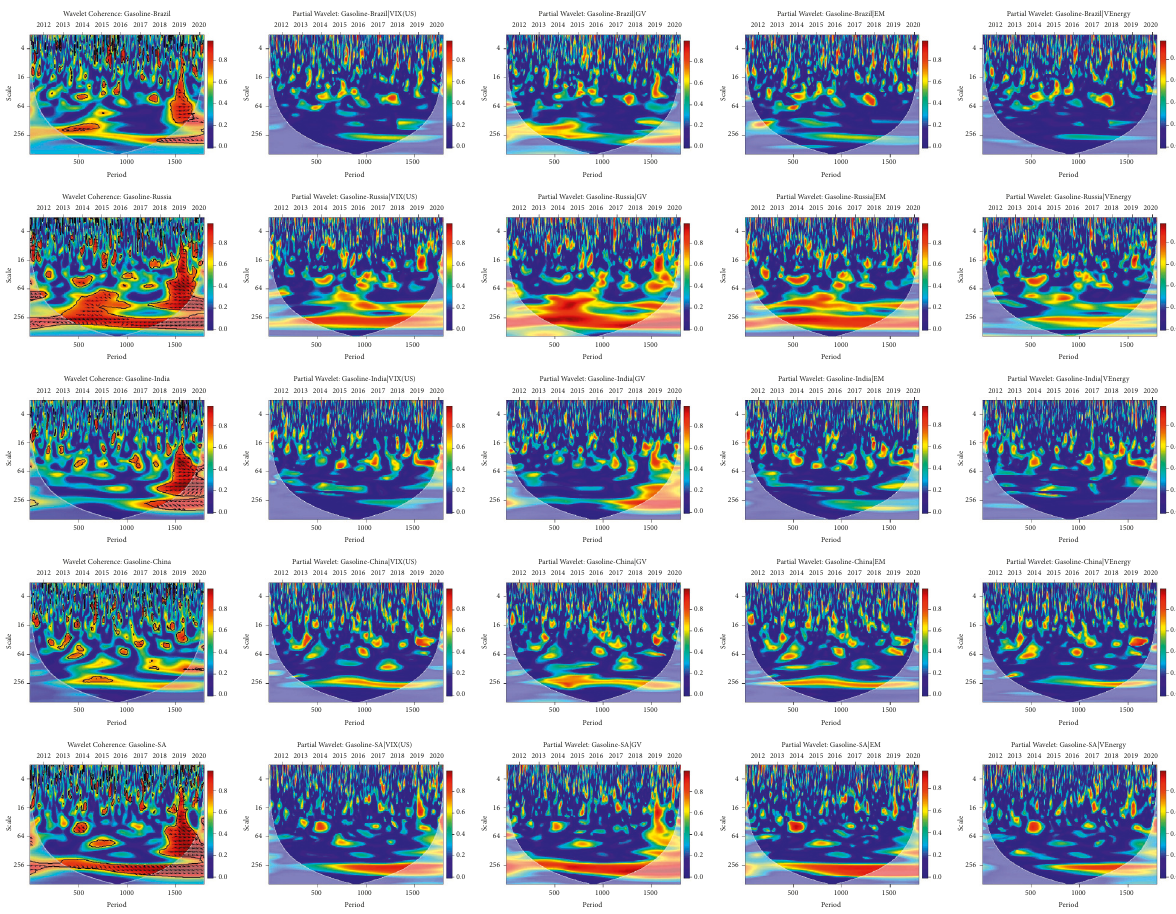
Figure 5: Comovements among gasoline, BRICS, and volatility